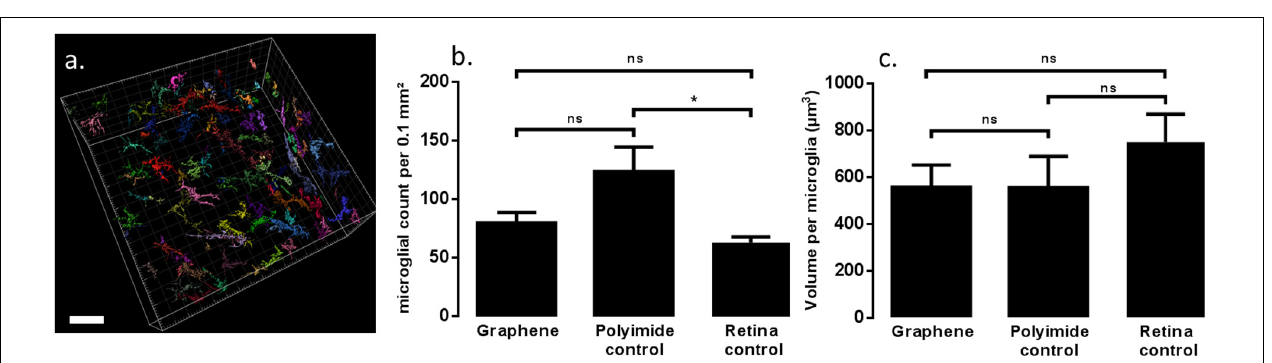
FIGURE 6 | Modeling of microglia based on Iba1 marker on retinal tissue in contact with devices with graphene (a) . Each different color represent a different microglial. Scale bars are 50 µ m. Graph (b) is the statistical analysis of microglial count comparing retinal tissue in contact with the two types of implant and retinal tissue from non-operated eyes. Graph (c) is the comparison of microglial volume between the three conditions. ns indicates p > 0.05, * indicates p ≤ 0.05.